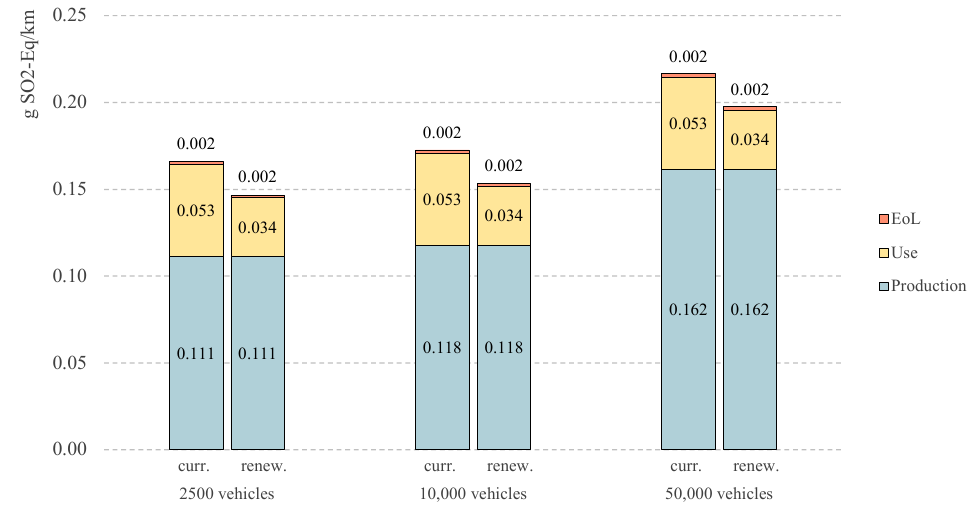
Figure 9. Lifetime acidification potential of e-moped fleets per kilometer; curr.—current German electricity mix of 2019, renew.—power grid mix resembling 100% renewable